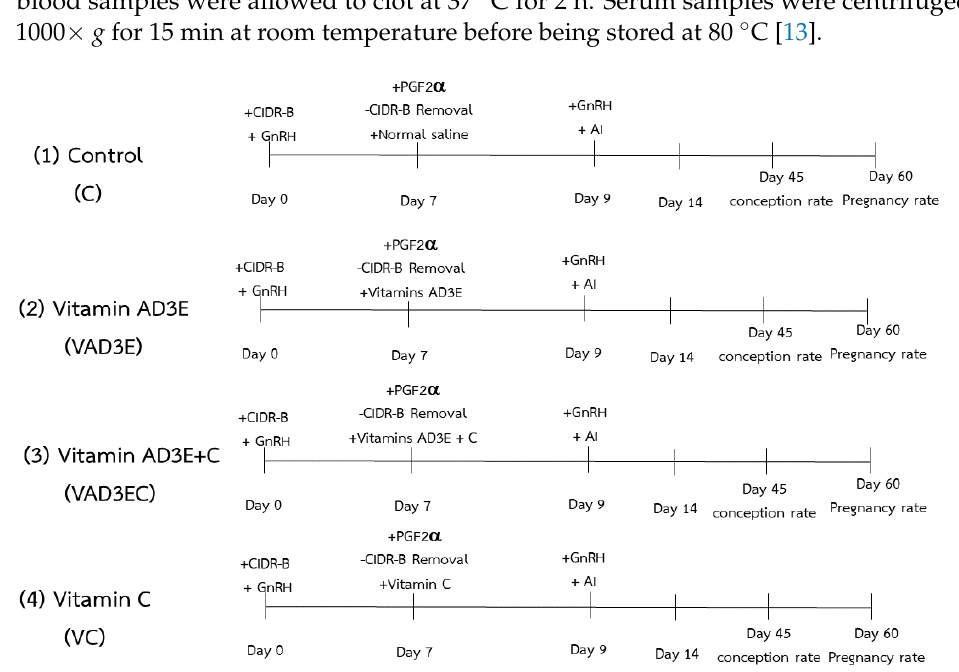
Figure 1. Diagram showing estrous synchronization plus timed AI protocol. (1, C): the control treatment for which cows were injected with normal saline; (2, VAD3E): cows injected with vitamin AD3E; (3, VAD3EC): cows received both vitamins AD3E and C; (4, VC): cows injected with vitamin C; CIDR–B: progesterone release device; GnRH: gonadotropin–releasing hormone analogue; PGF2 α : prostaglandin F2 alpha; AI: artificial insemination.